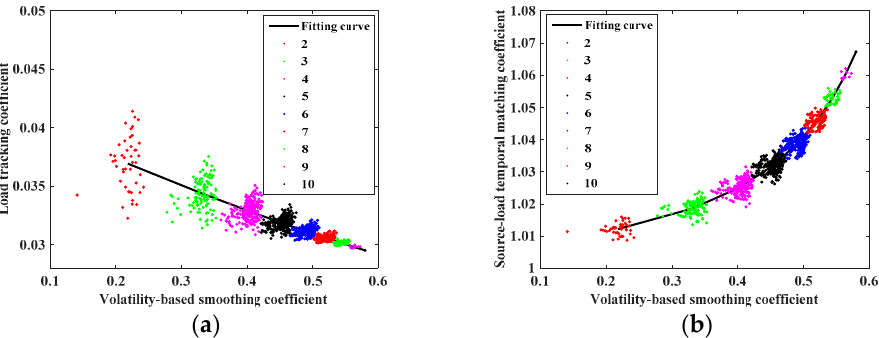
Figure 6. The source-load timing matching degree under different wind farm combinations (assumption). ( a ) The load tracking coefficient; ( b ) The source-load timing matching coefficient.